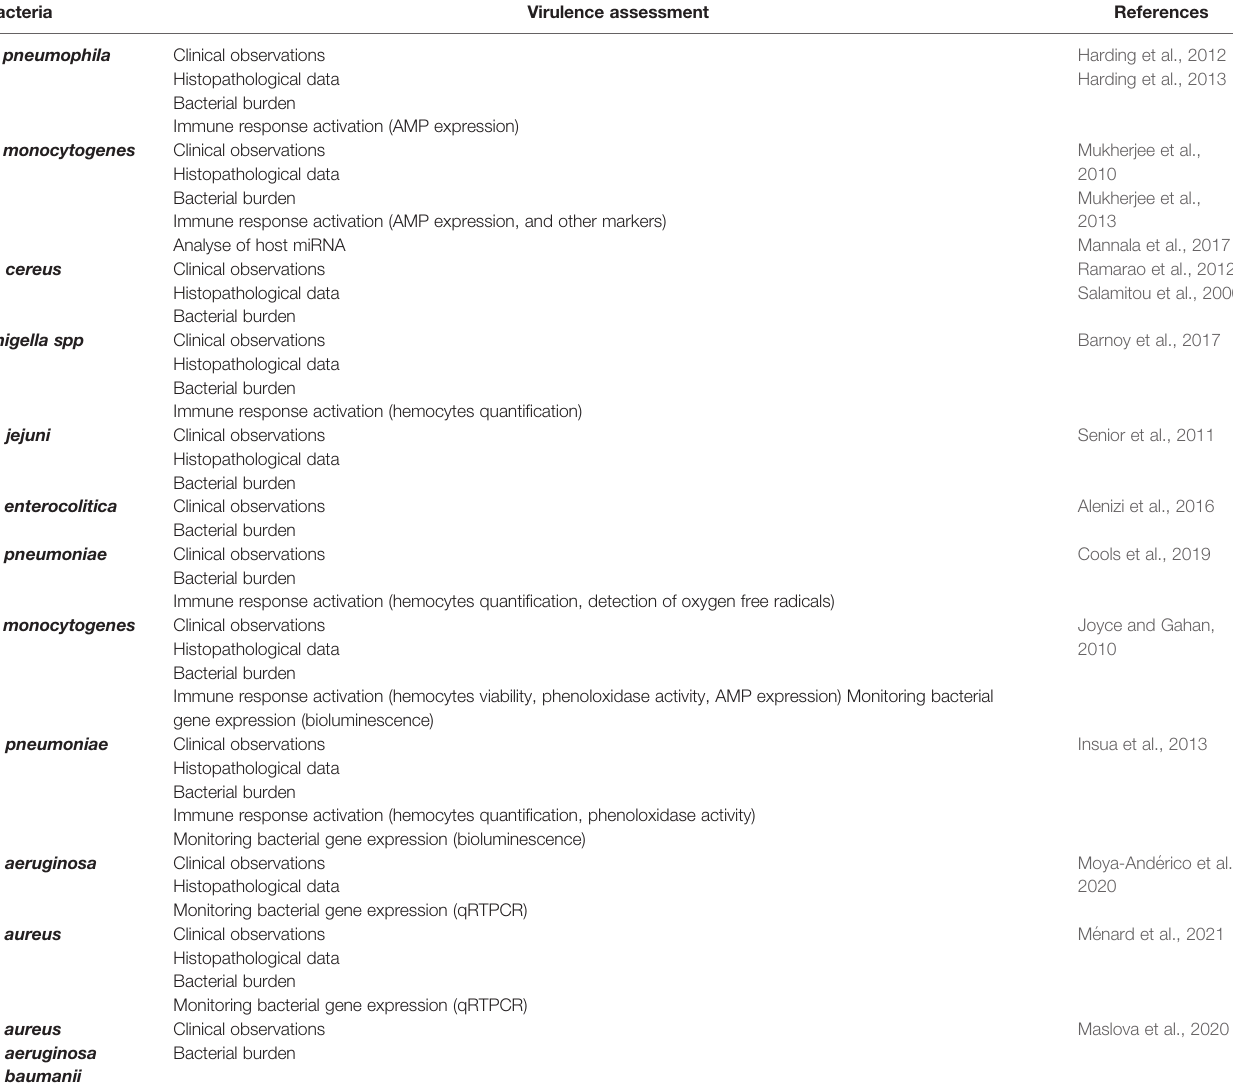
TABLE 1 | Selected studies focusing on bacteria-G. mellonella interactions throw different virulence assessments.